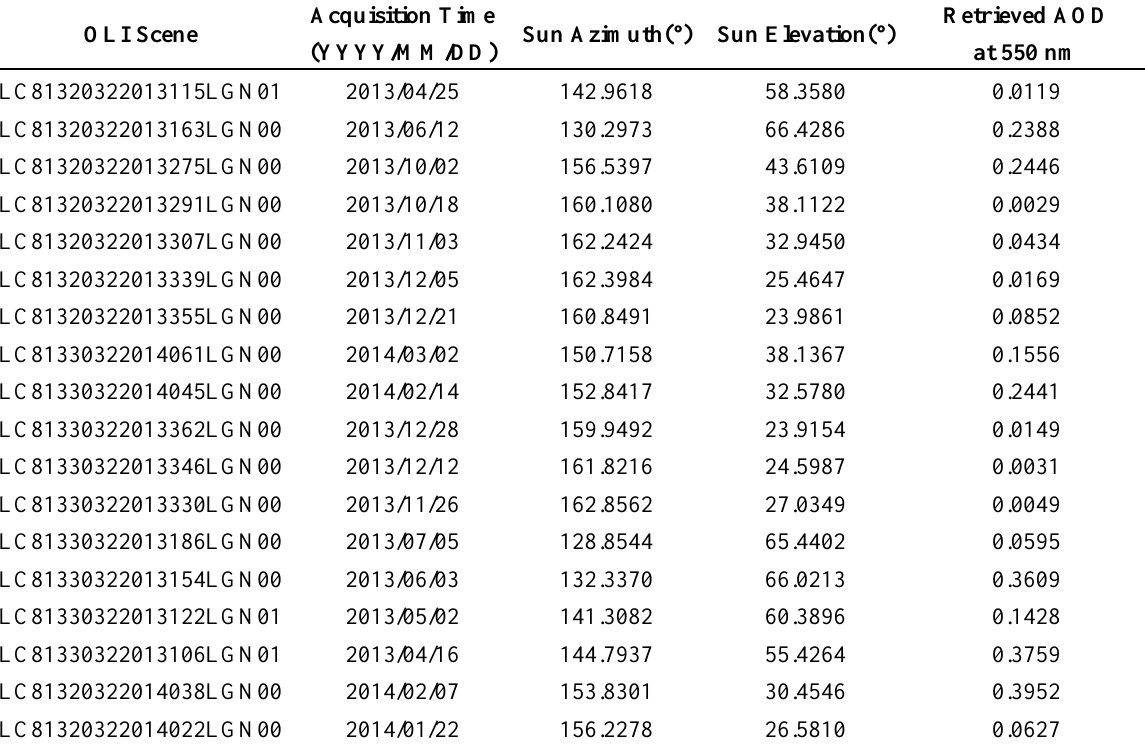
Table 6. Acquisition times and retrieved AODs of the selected